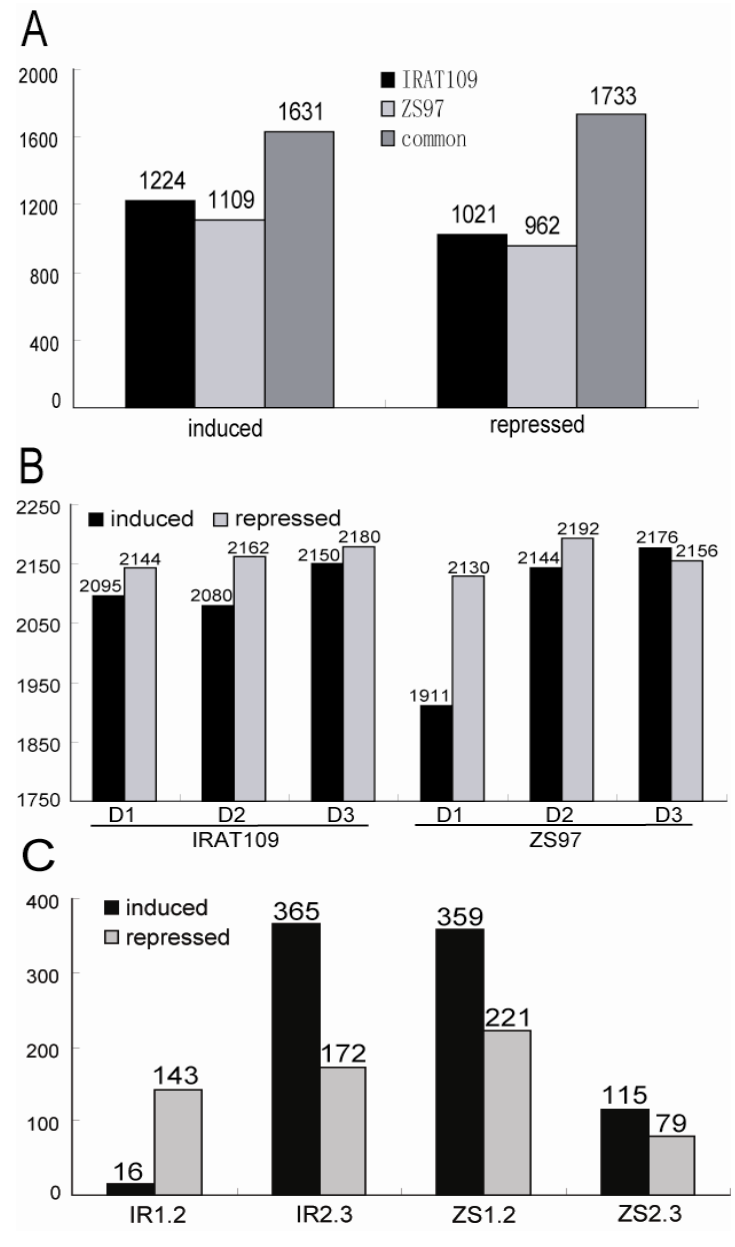
Figure 2. The number of differentially expressed genes (with p < 0.05 as threshold). ( A ) Total number of induced and repressed genes in IRAT109, ZS97 and both; ( B ) Numbers of genes significantly up- or downregulated at D1, D2 and D3 stages of drought stress compared to non-stress condition; ( C ) Number of differentially expressed genes among different time points. IR1.2 and ZS1.2: number of differentially expressed ( i.e. , significantly up- or downregulated) genes between D1 and D2 in IRAT109 and ZS97, respectively. IR2.3 and ZS2.3: number of differentially expressed genes between D2 and D3 in IRAT109 and ZS97,